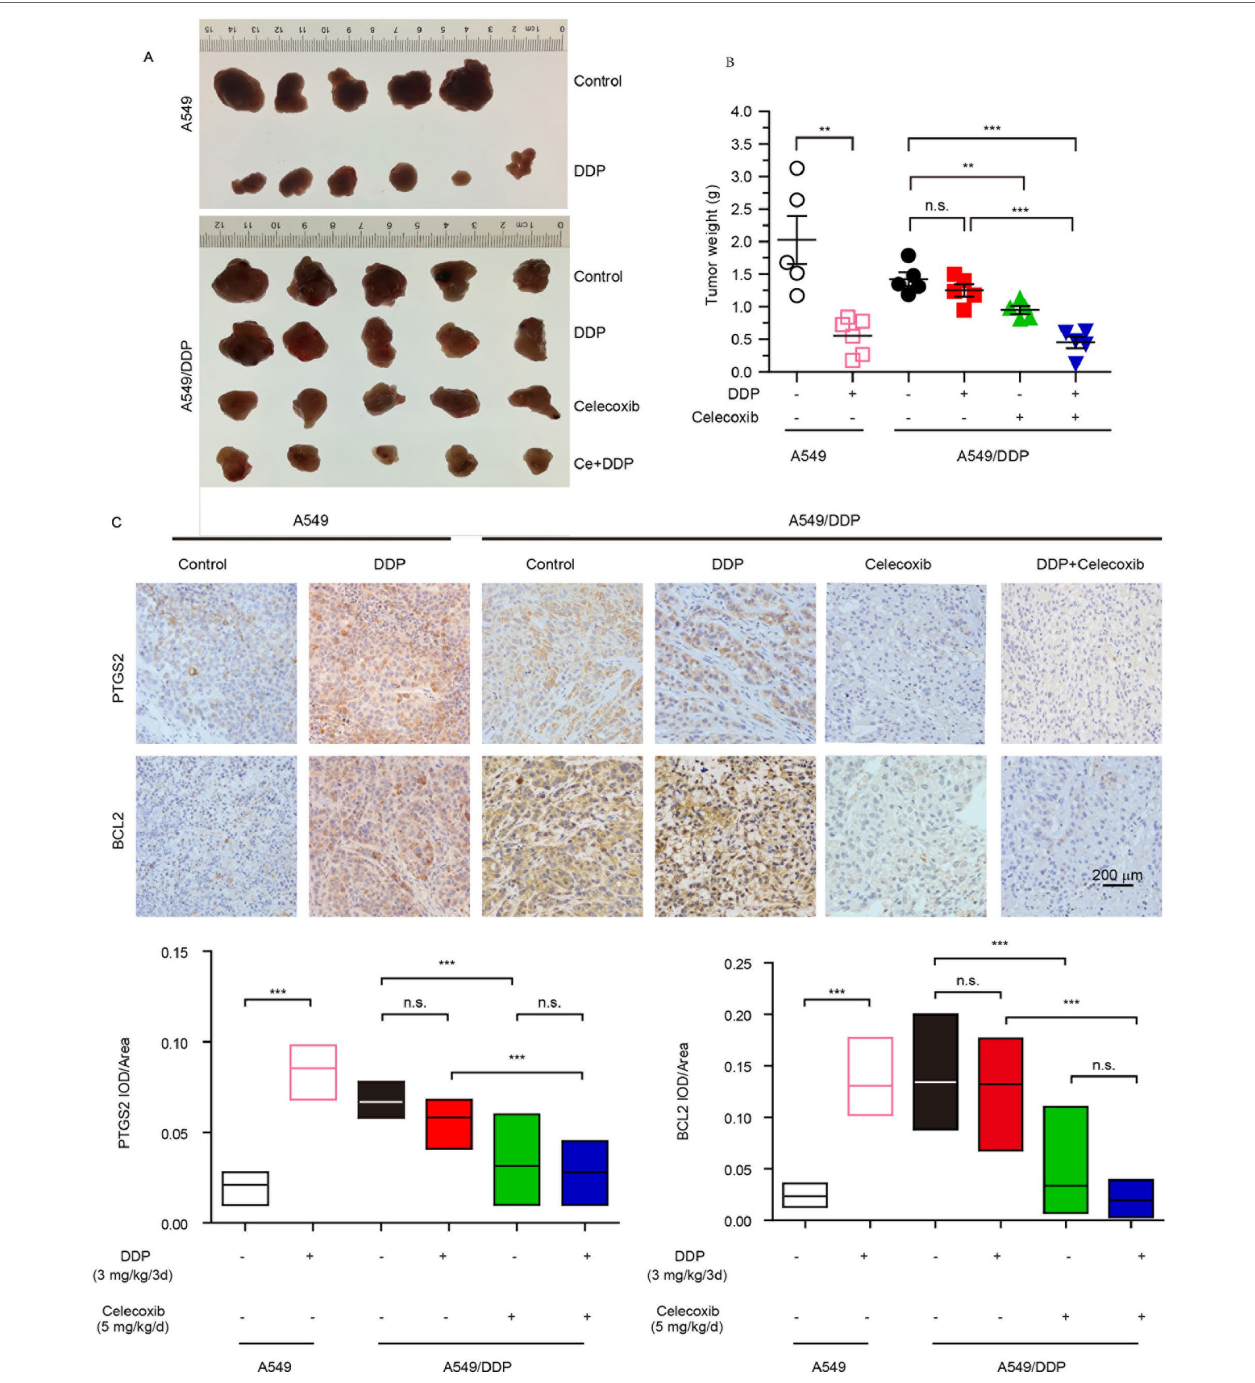
FIGURE 6 | PTGS2 inhibitor reversed the resistance to cisplatin in vivo . The A549 (1 × 10 7 cells) and A5491/DDP cells (5 × 10 6 cells) were injected into the flank of 5-week-old male BALB/c nude mice, which were randomly distributed into groups. (A and B) Tumors were weighted after tumor dissection. (C) Immunohistochemistry was carried out by probing with anti-PTGS2 mAb (upper) and anti-BCL2 mAb (lower). ** P < 0.01, *** P < 0.001, “n.s.” means “no